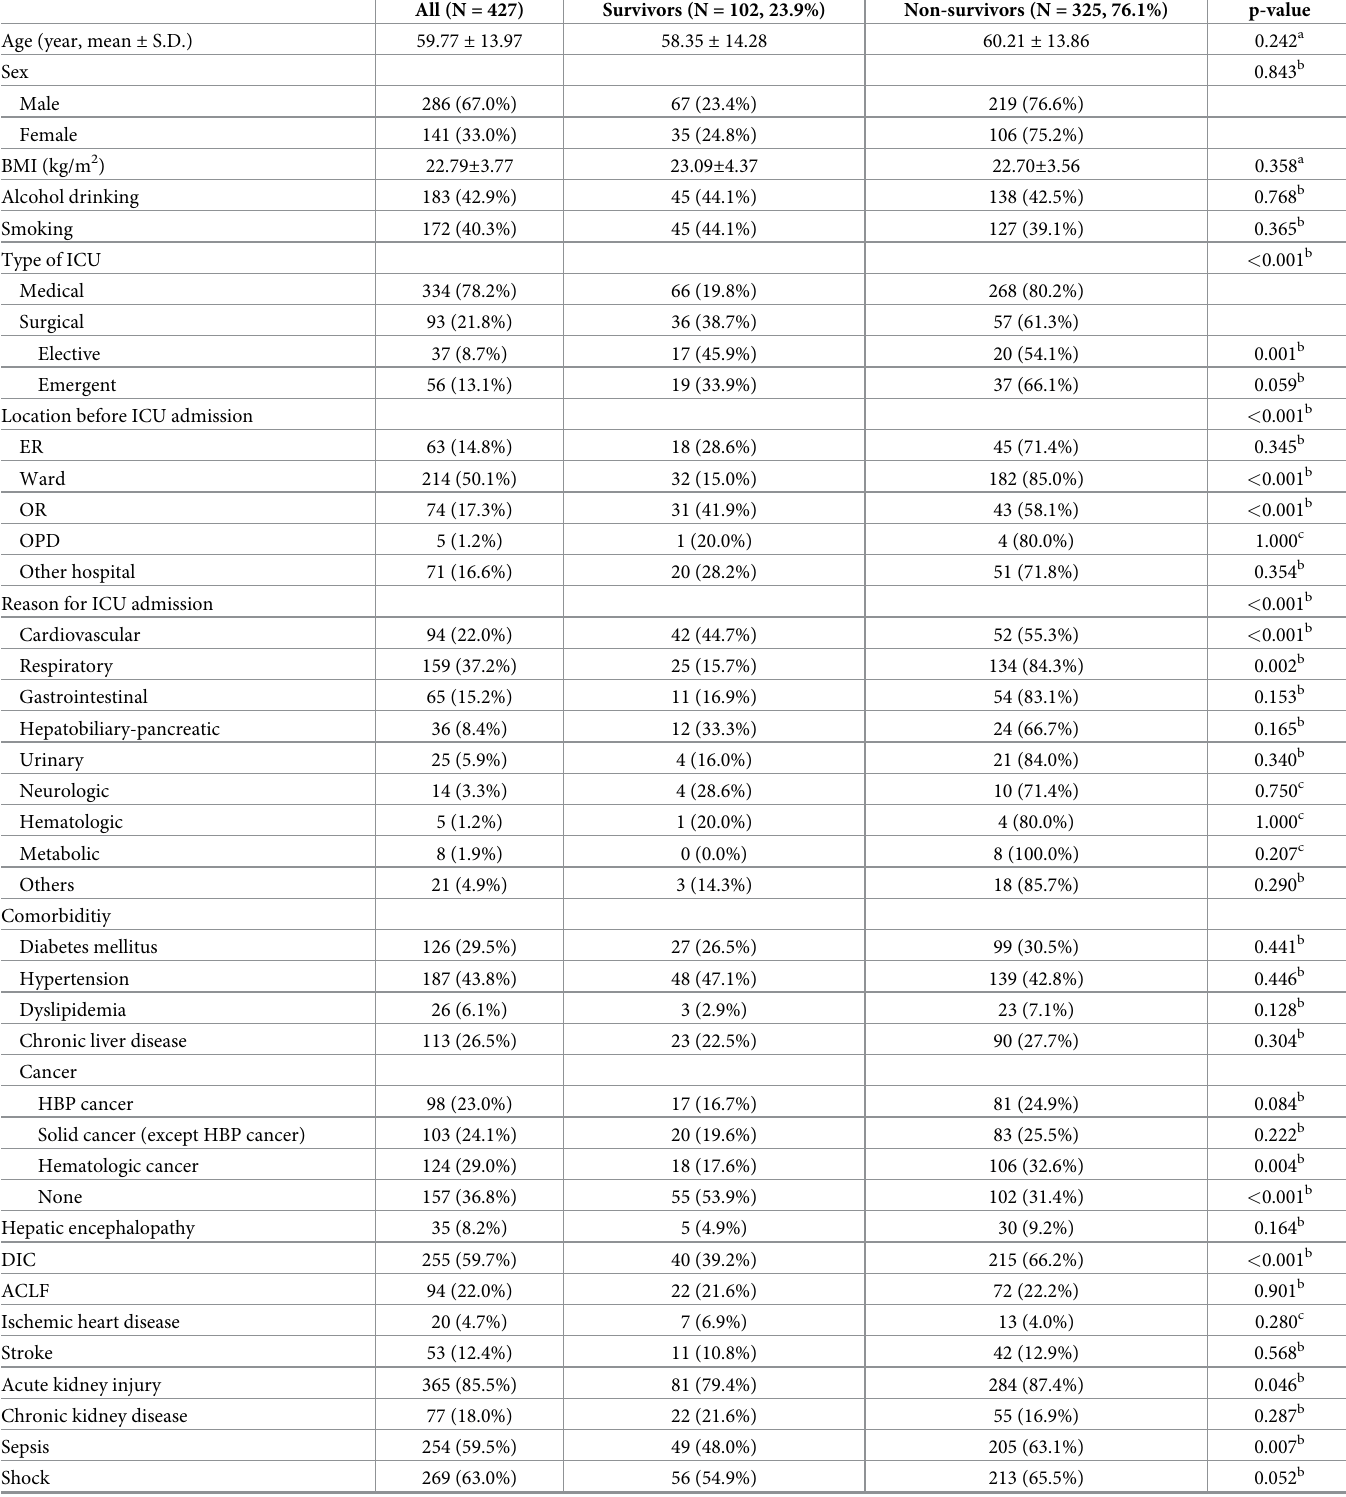
Table 1. Baseline characteristics with comparison between survivors and